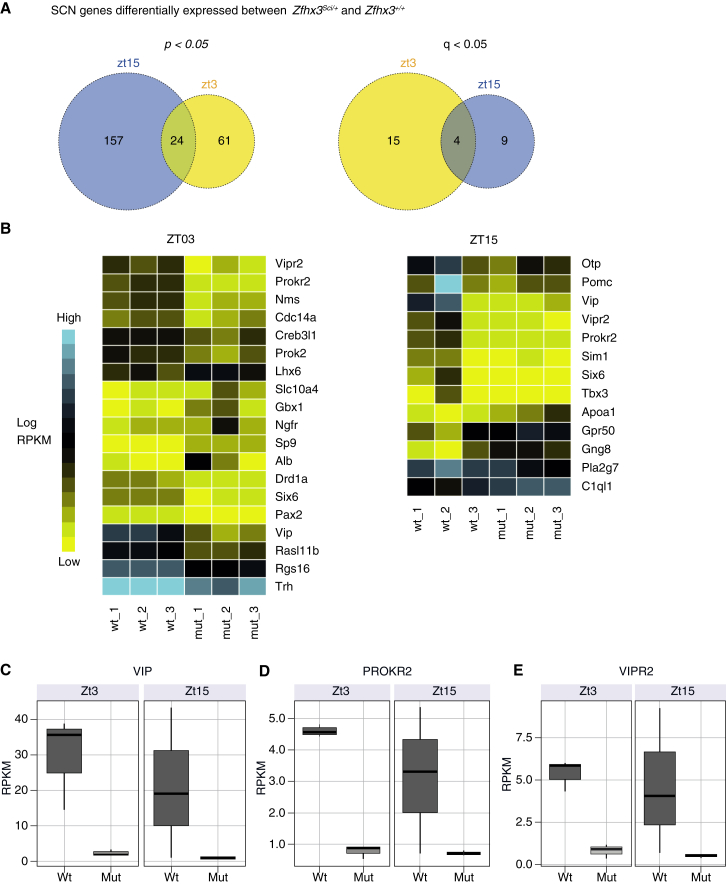
RNA Sequencing Reveals Transcripts Differentially Expressed in Zfhx3Sci/+ SCN(A) Venn diagrams depicting the number of differentially regulated transcripts, at ZT3 and ZT15, with a log2 fold change of >1 between Zfhx3Sci/+ and Zfhx3Sci/+ SCN. Genes were considered differentially expressed if they passed significance (left, p < 0.05; right, q < 0.05) for at least one of the three analysis methods (EdgeR, DESeq, or Cufflinks).(B) Transcripts with significant q values at each time point were used to populate heatmaps. For each time point, a heatmap shows the average expression in reads per kilobase per million (RPKM) for each transcript. wt, wild-type; mut, mutant.(C–E) Representative box plots of gene expression for (C) Vip, (D) Prokr2, and (E) Vipr2 (q < 0.05).See also Tables S1 and S2.